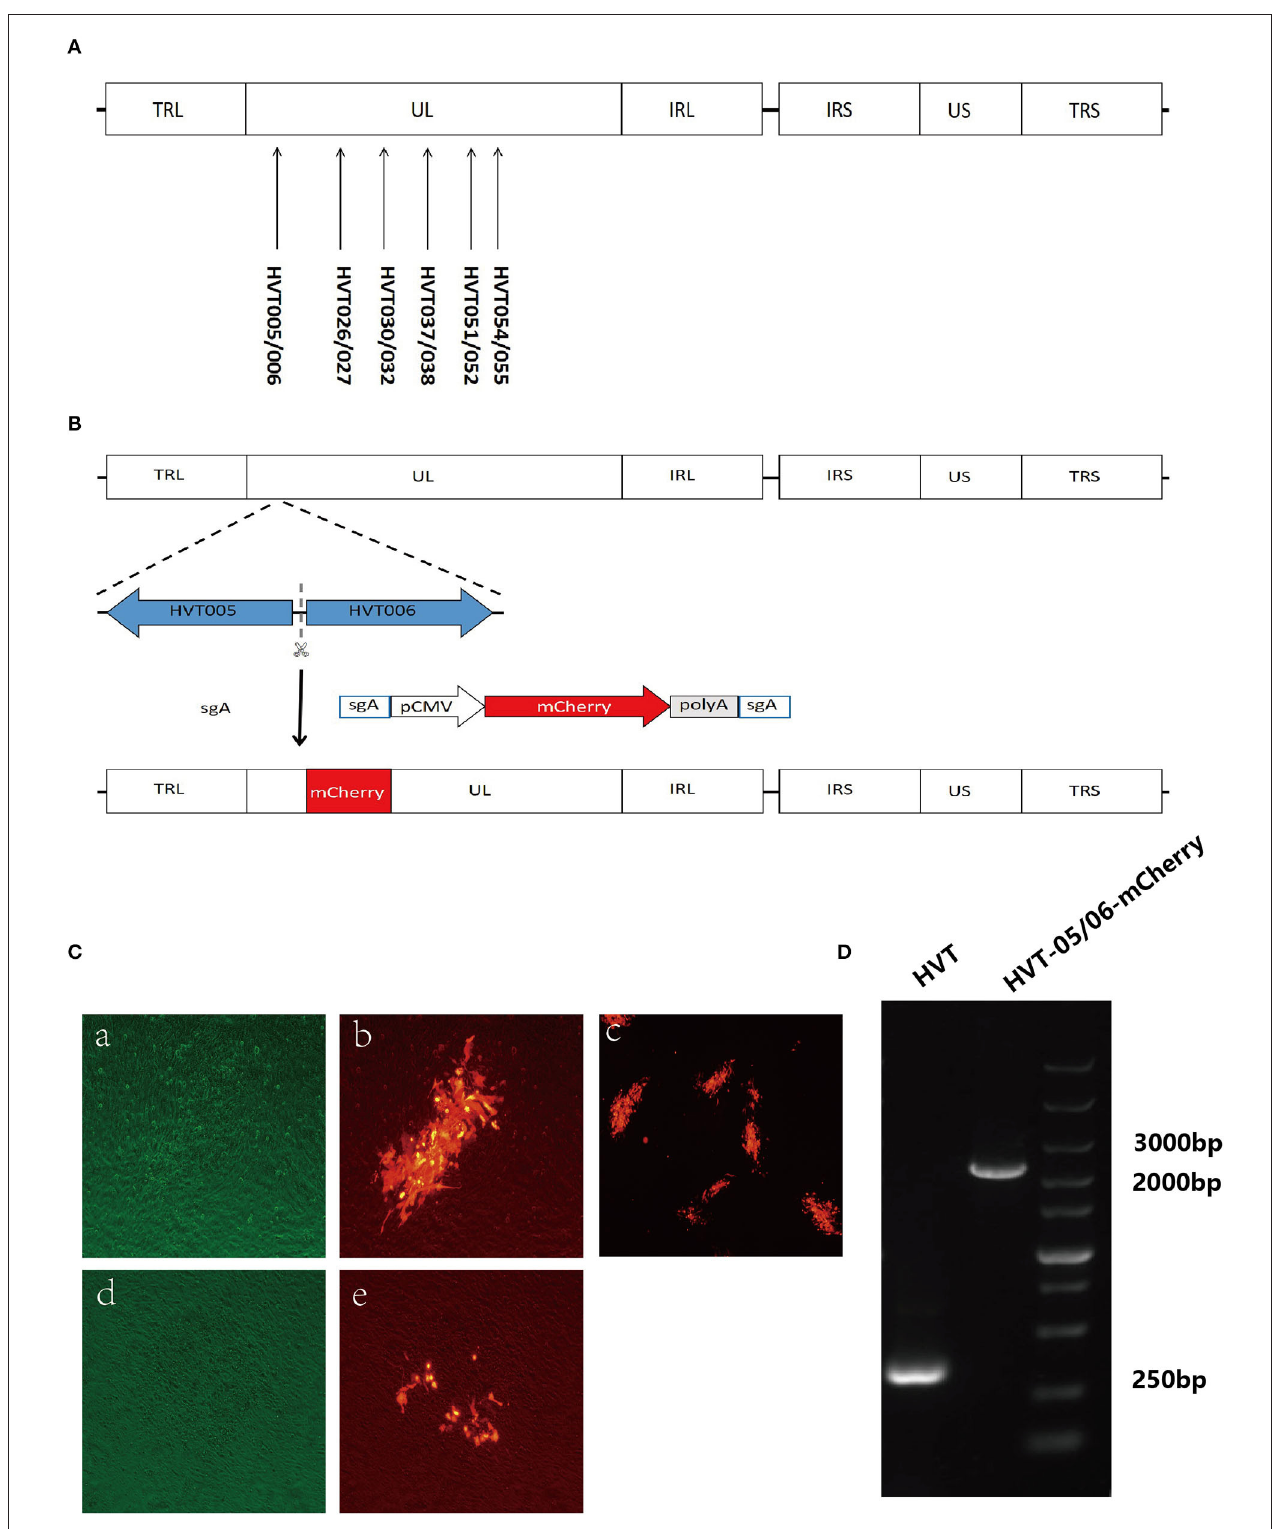
FIGURE 1 | Screening for new insertion sites in the UL region of the HVT genome and construction of recombinant HVT-mCherry. (A) Location of the new insertion sites in the HVT genome. (B) Schematic presentation of the construction of recombinant HVT-005/006-mCherry. The mCherry cassette was flanked by sgA